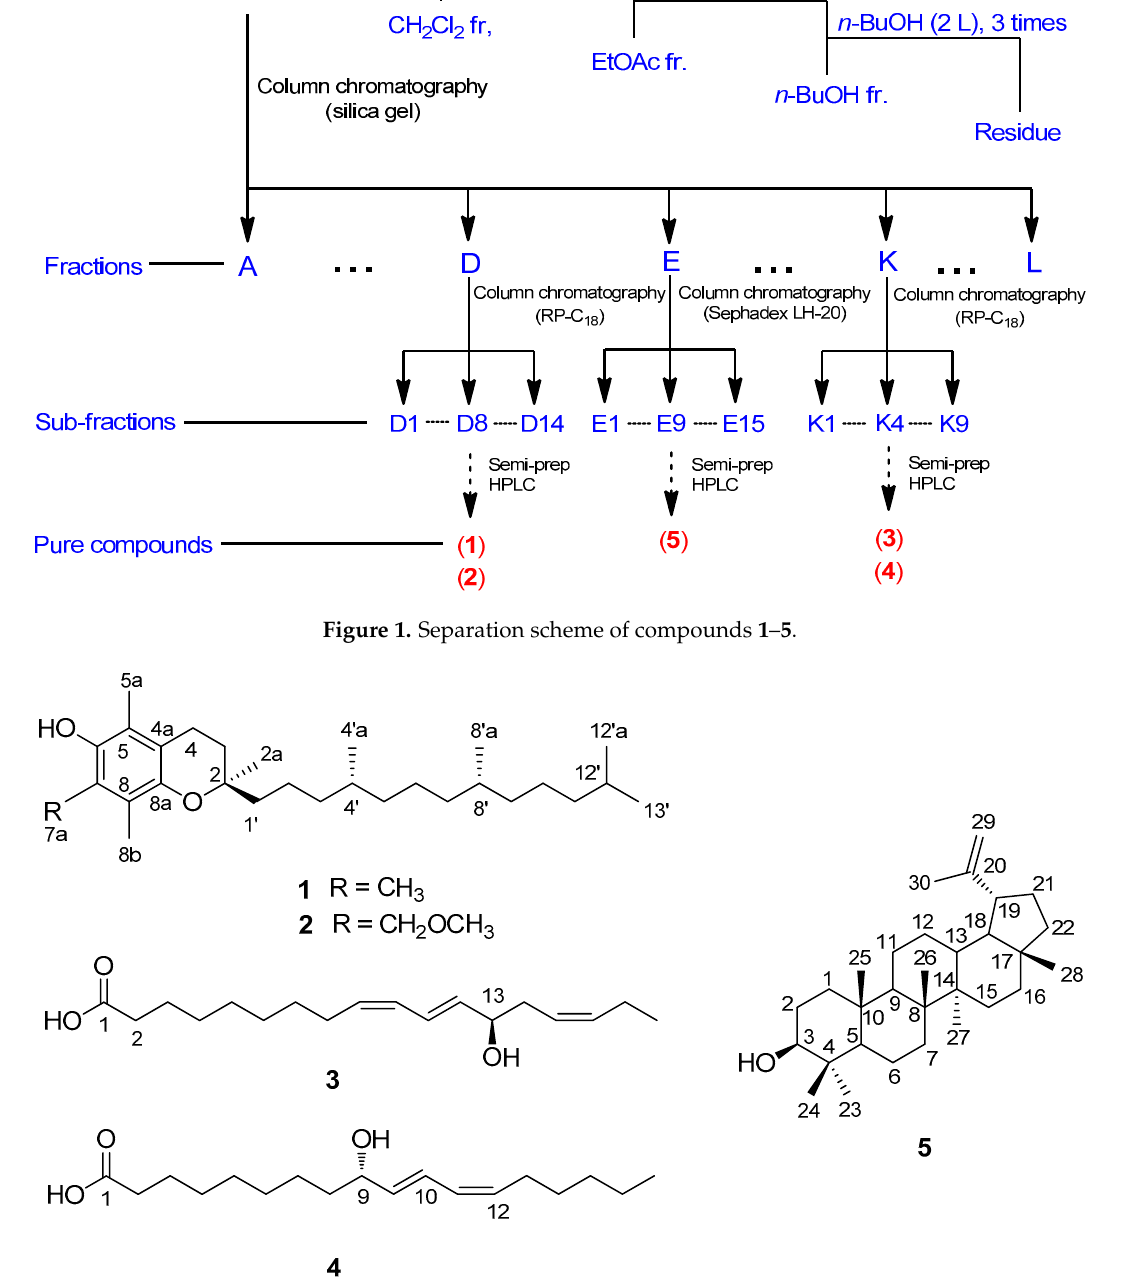
Figure 2. Chemical structures of compounds ( 1–5 ) separated from L. cuneata .